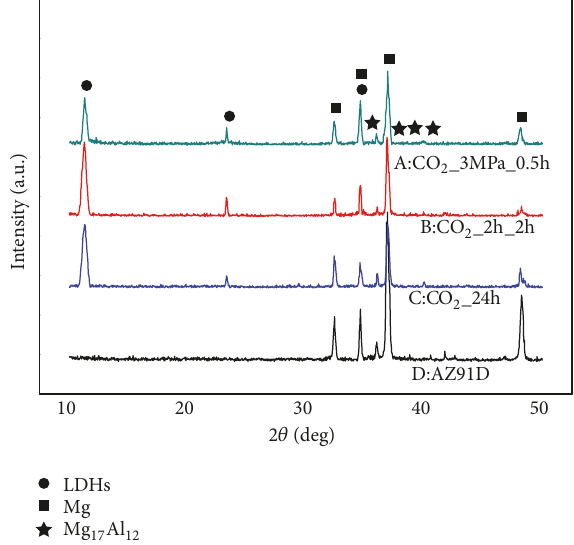
Figure 6: GAXRD patterns of the AZ91D alloy with and without conversion coating.